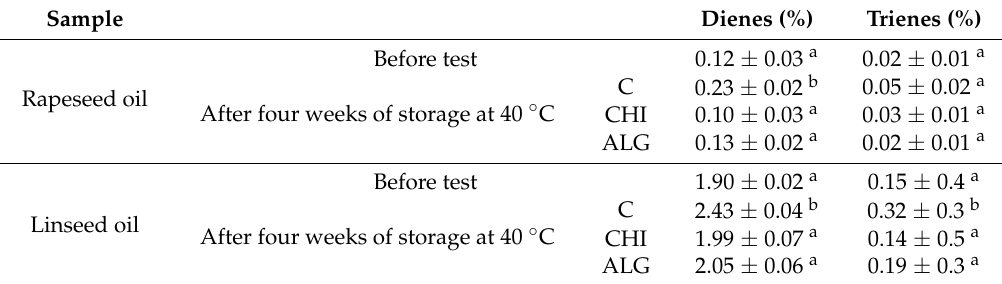
Table 8. Comparison of dienes and trienes content in rapeseed and linseed